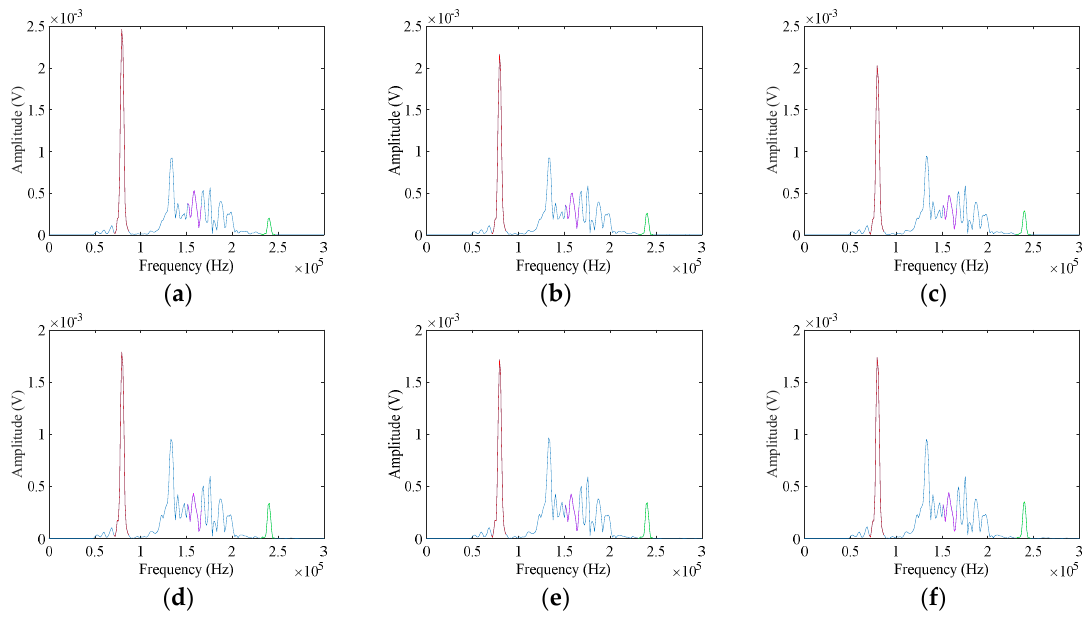
Figure 13. Marginal spectrum processed by WPT+DFT of different delamination damages. ( a ) 0 mm; ( b ) 4 mm; ( c ) 8 mm; ( d ) 12 mm; ( e ) 16 mm; ( f ) 20 mm.